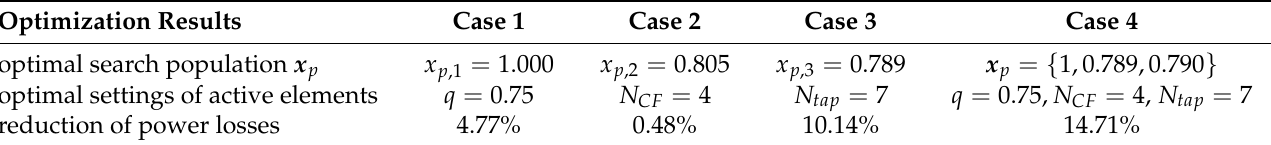
Table 1. Optimization of a single operation point for constant power loading model